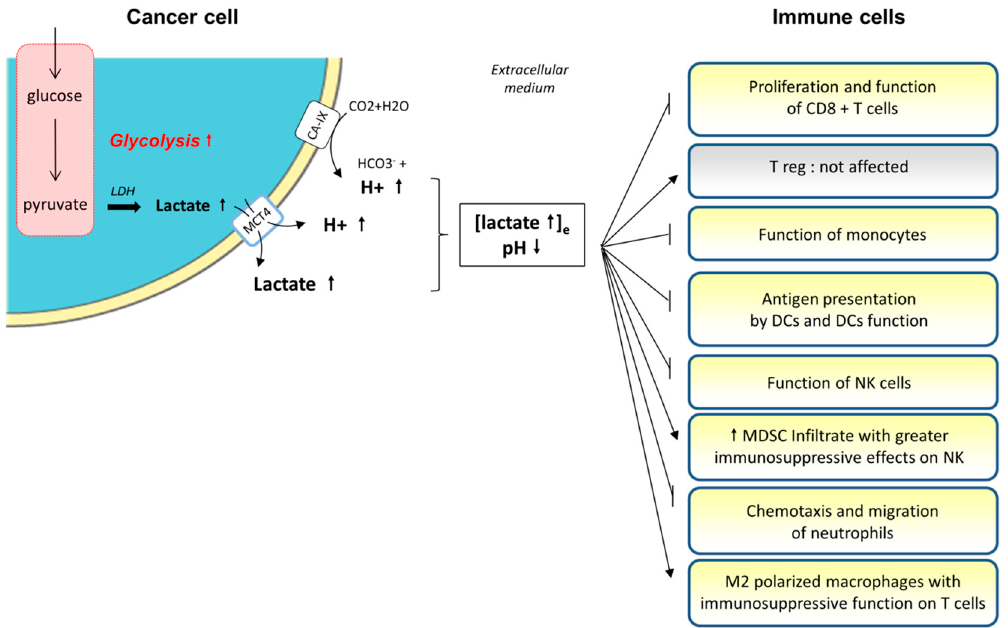
T cells (Treg) do not seem to be impaired by lactate and acidification, because of a different metabolism, based on fatty acid oxidation (FAO) [54].